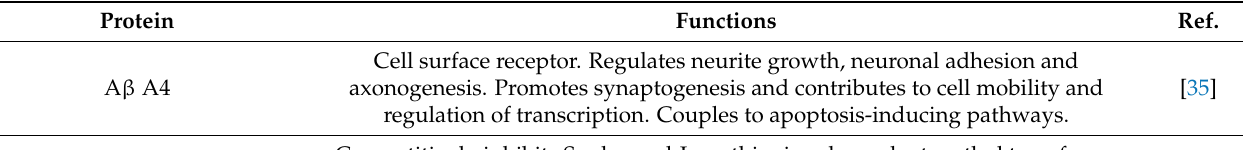
Table 1. A selection of AD-related proteins identified in Nosustrophine extracts. Protein Functions